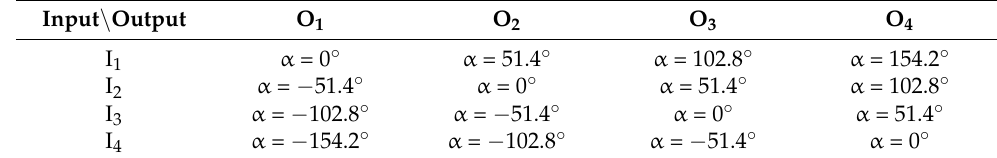
Table 1. Phase shifts α required for connecting the four I i transmitters with the four receivers O i .